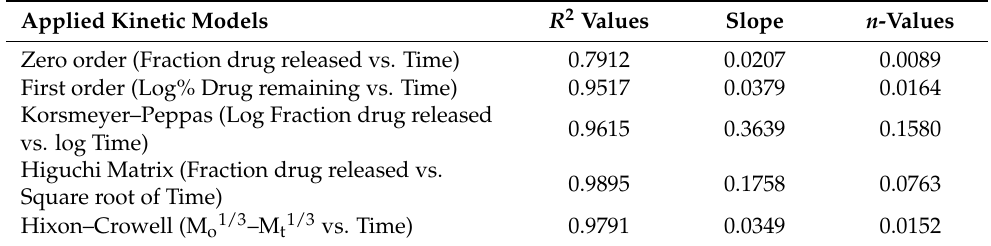
Table 2. Different release kinetics model equations with release exponents ( n -values).